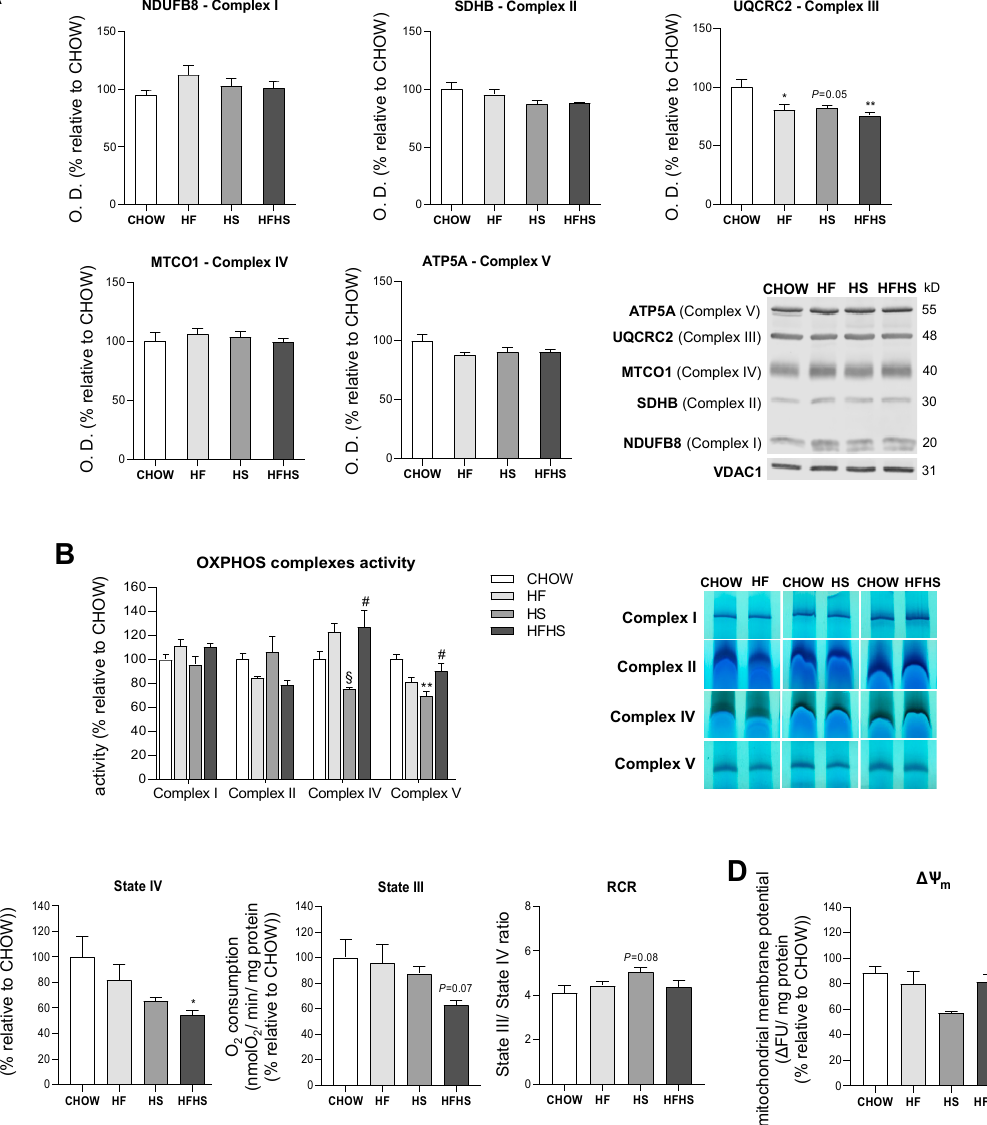
Figure 5. The HFHS diet decreases mitochondrial respiration. ( A ) Optical density (arbitrary units) of OXPHOS subunits (NDUFB8, Complex I; SDHB, Complex II; UQCRC2, Complex III; MTCO1, Complex IV; and ATP5A, Complex V) levels and representative Western blot images. VDAC1 was used as a loading control ( N = 4). ( B ) OXPHOS complex activities and in-gel activities representative image ( N = 4). ( C ) Oxygen consumption rate in the basal state (State IV) and in the ADP-stimulated state (State III) and RCR (State III/State IV) ( N = 6). ( D ) Mitochondrial membrane potential ( N = 8). All data are expressed as the mean ± SEM. (*) vs. the CHOW diet, (§) vs. the HF diet and (#) vs. the HS